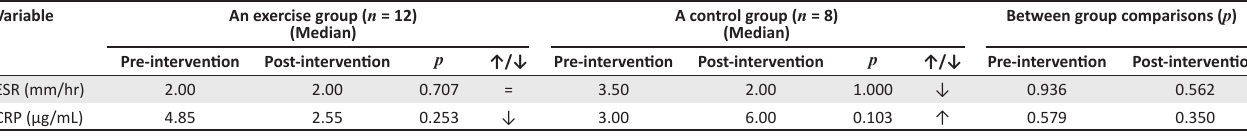
TABLE 3: Blood assessments pre-and post-intervention, within and between groups ( n = 20). Variable An exercise group ( n = 12)